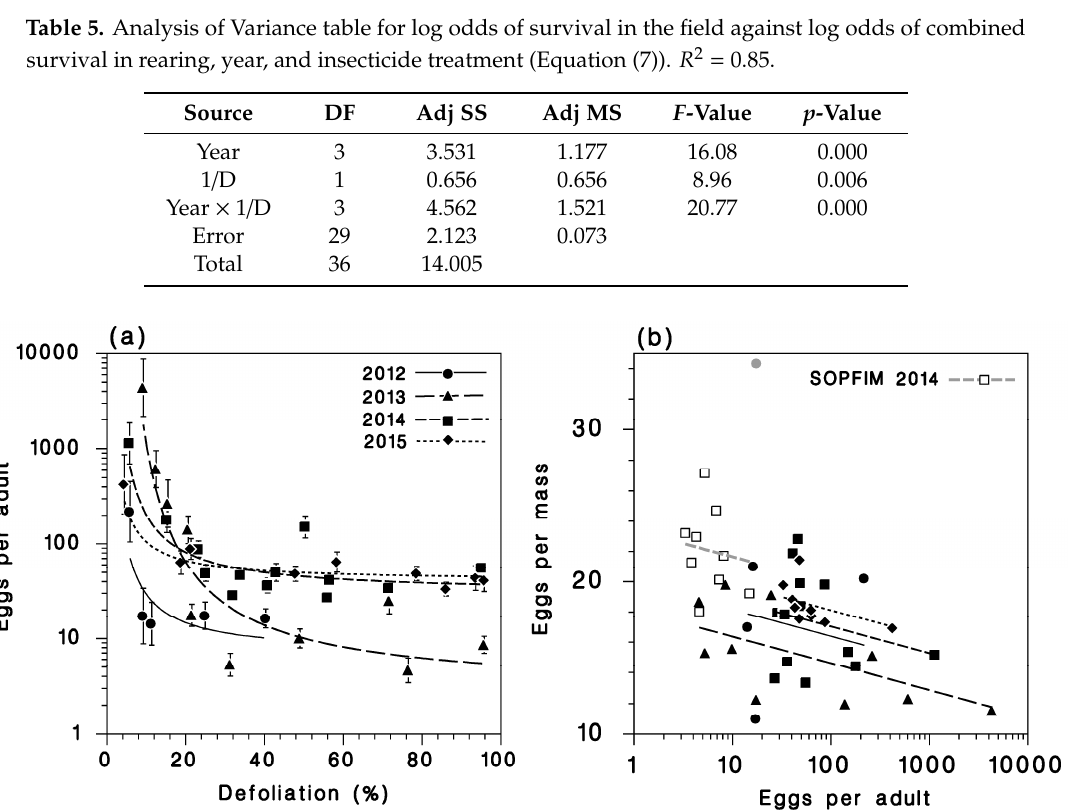
Figure 8. Relationships between ( a ) apparent fecundity and defoliation (Equation (7)) and ( b ) egg mass size and apparent fecundity (Equation (8)). Greyed symbol in ( b ): Outlier omitted from analysis.